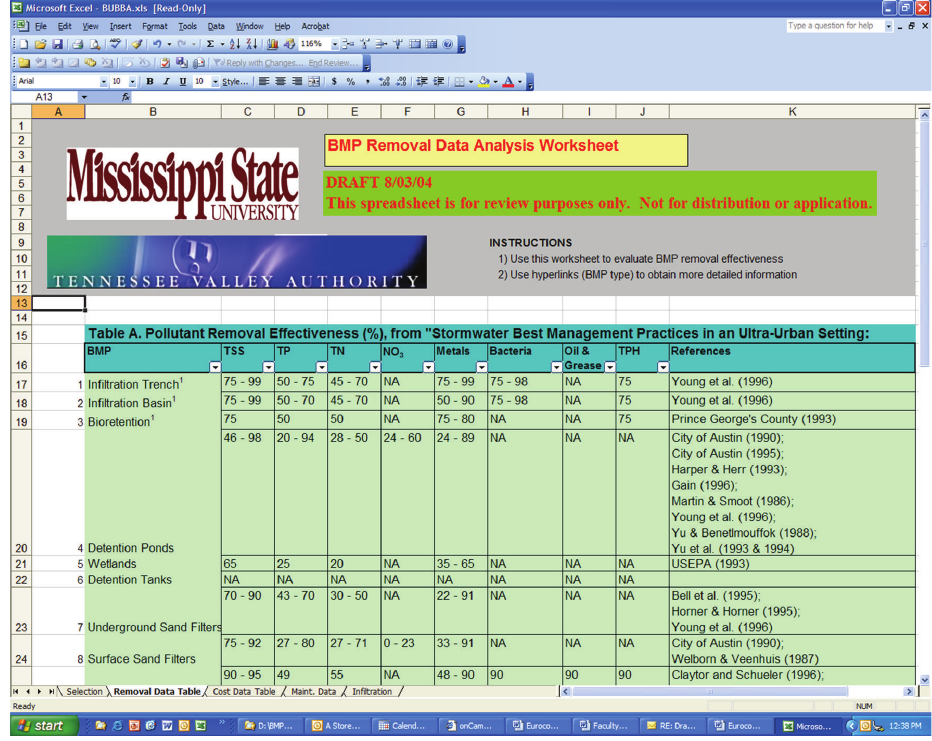
Figure 3: Removal Data Table